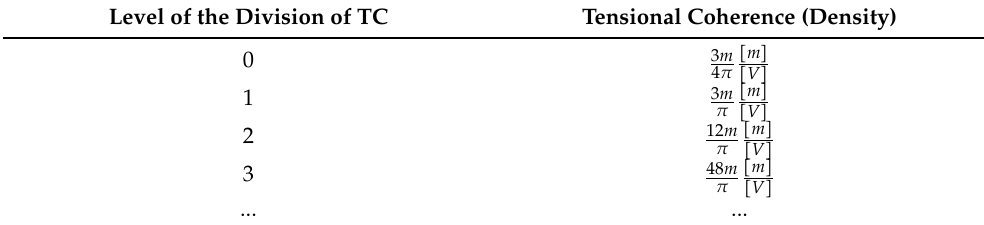
Table 2. Tensional coherences of the levels of the division of